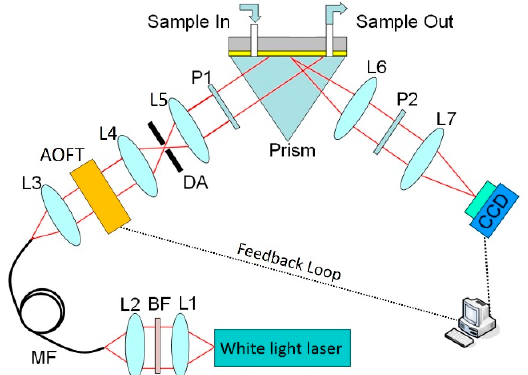
Figure 2. Schematic of our SPRi system in the Kreschmann configuration. Light from a white light laser is collected by a multimodal fiber through a set of coupling optics. At the exit end of the fiber, the beam is collimated by a group of lenses and spatially filtered by an aperture before passing through the tunable spectral filter unit and a linear polarizer. The sensor surface is imaged by a CCD camera using two imaging lenses. L1–L7: lens; BF: bandpass filter; MF: multimode fiber; DA: diaphragm aperture; AOTF: acousto-optic tunable filter; P1 and P2: polarizer.